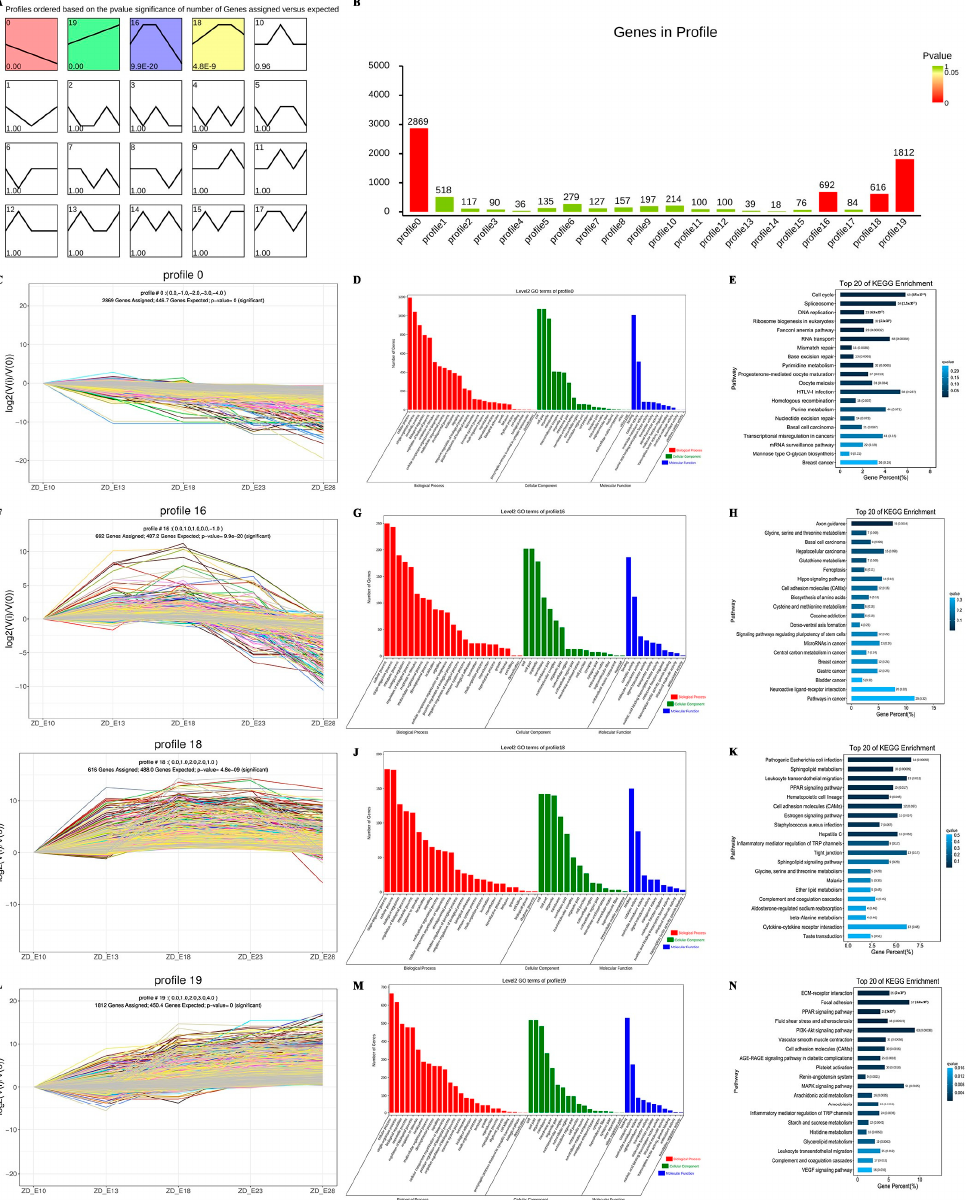
Figure 5. Trend analysis of differential genes for skin and feather follicle development in Zhedong white geese. ( A ) Summary of trends in differentially expressed genes (DEGs). The colored profiles ( p < 0.05) indicate significant enrichment and, conversely, non-significant enrichment. Similar color patterns are shown in profiles with the same expressive tendency. ( B ) The number of genes in a gene profile. ( C – E ) Trend plots, GO and KEGG analysis of profile 0. ( F – H ) Trend plots, GO and KEGG analysis of profile 16. ( I – K ) Trend plots, GO and KEGG analysis of profile 18. ( L – N ) Trend plots, GO and KEGG analysis of profile 19. Profiles C-F-E-L: Each X -axis indicates the embryonic stages (E10, E13, E18, E23, and E28); the Y -axis displays variations in expression. Four profiles (profiles C-F-E-L) represent the major transcriptional trajectories.